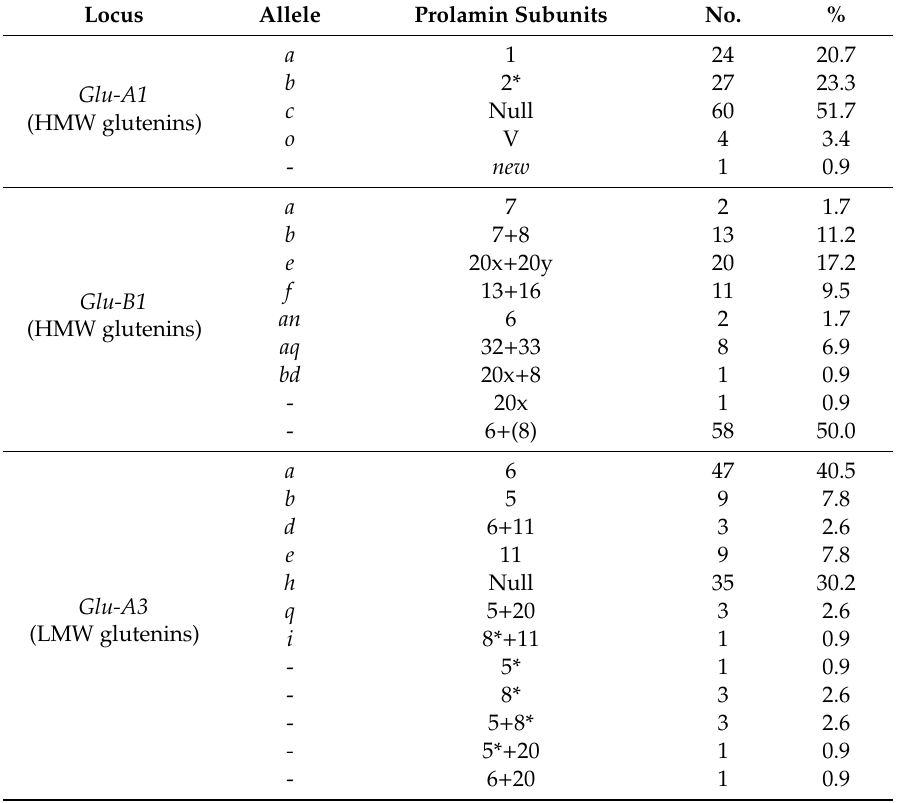
Table 1. Frequency of the di ff erent high molecular weight (HMW) and low molecular weight (LMW) glutenin subunits and γ -gliadins observed for loci Glu-1 , Glu-3 , Glu-B2 , and Gli-B1 in the 116 durum wheat landraces analyzed. The allele correspondence is indicated for those variants that have been already designated. Locus